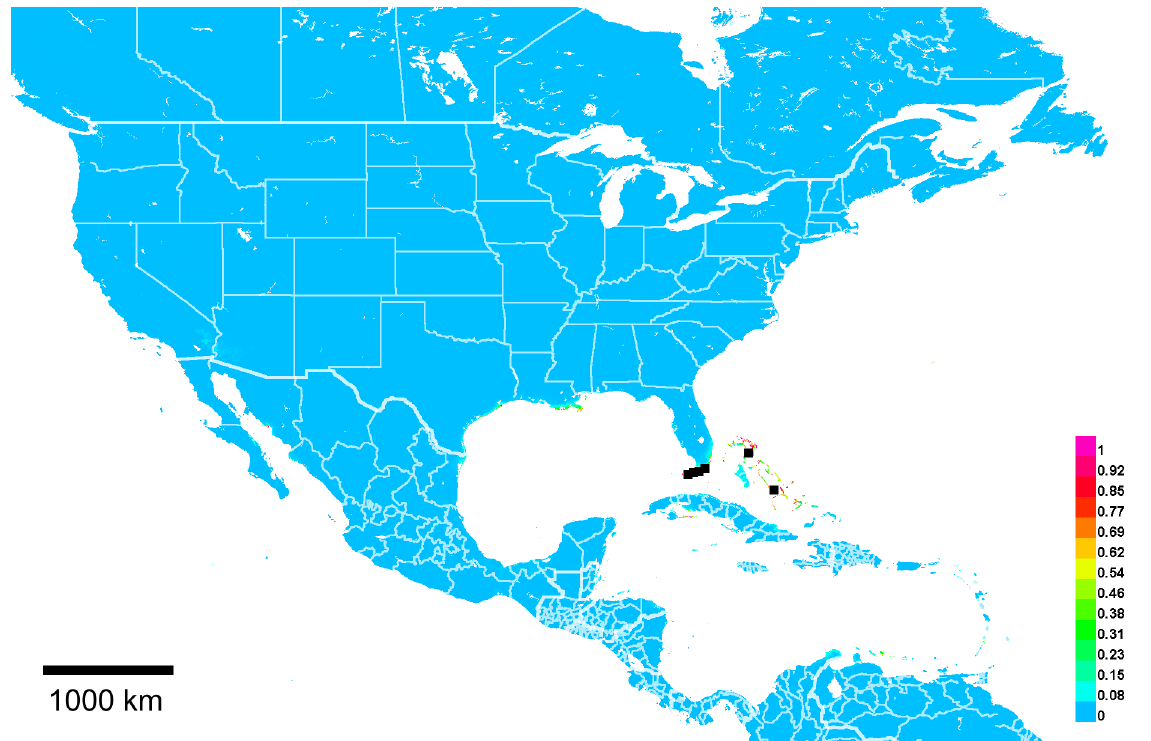
Fig. 69. Georeferenced collection records of Lasioglossum ( D .) surianae (Mitchell, 1960) (black squares) and predicted distribution by maximum entropy ecological niche modelling in Maxent (colour shading). Warmer colours indicate higher cloglog probability of occurrence. Because many coastal records lacked soil data, the model was generated without soil type as an environmental